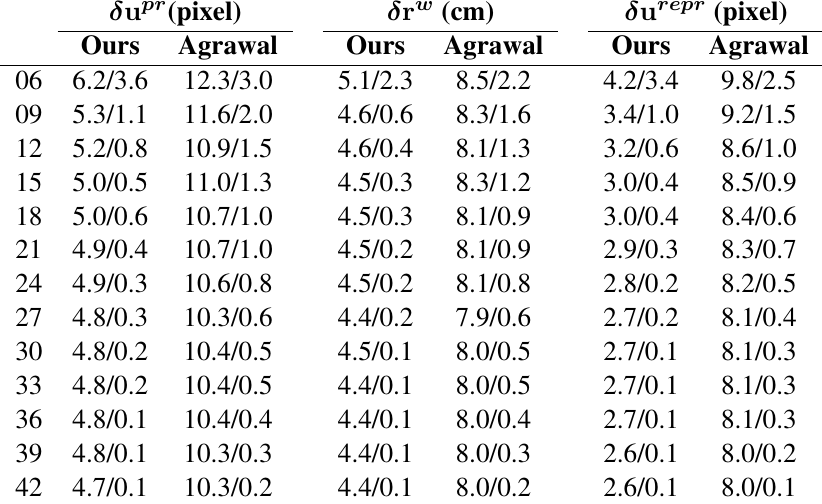
Table 1. Accuracy comparison between our method and the method of Agrawal et al . The first column represents the number of training samples. The numbers are listed as “a/s” where a is the average over 100 experiments and s is the standard